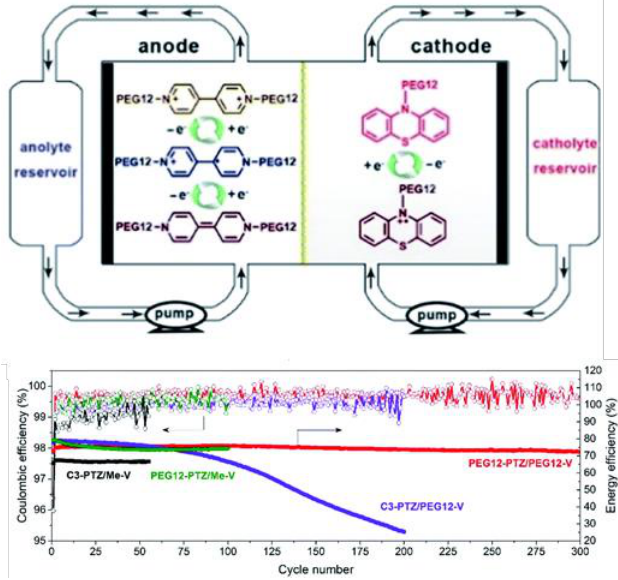
Figure 10. ( Top ) Design of the all − PEGylated AORFB by Chai et al., employing viologen and PEGylated phenothiazine as anolyte and catholyte, respectively. ( Bottom ) Monitoring of the capacity of charge/discharge cycles and the Coulombic efficiency of the all − PEGylated AORFB over 300 cycles (2 mA cm −2 ). For comparison with non − PEGylated derivatives, dimethylviologen (Me − V) and N − propylphenothiazine (C3 − PTZ) were also measured. Reproduced with permission from Chai et al. [146], copyright Royal Society of Chemistry.